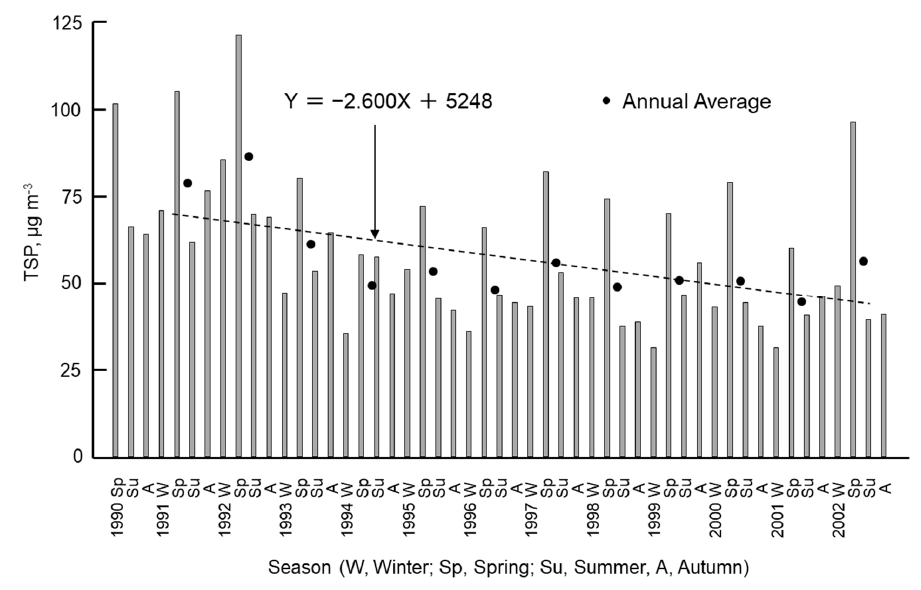
Figure 1. Atmospheric concentration of TSP in Sapporo from 1990 to 2002 by season.